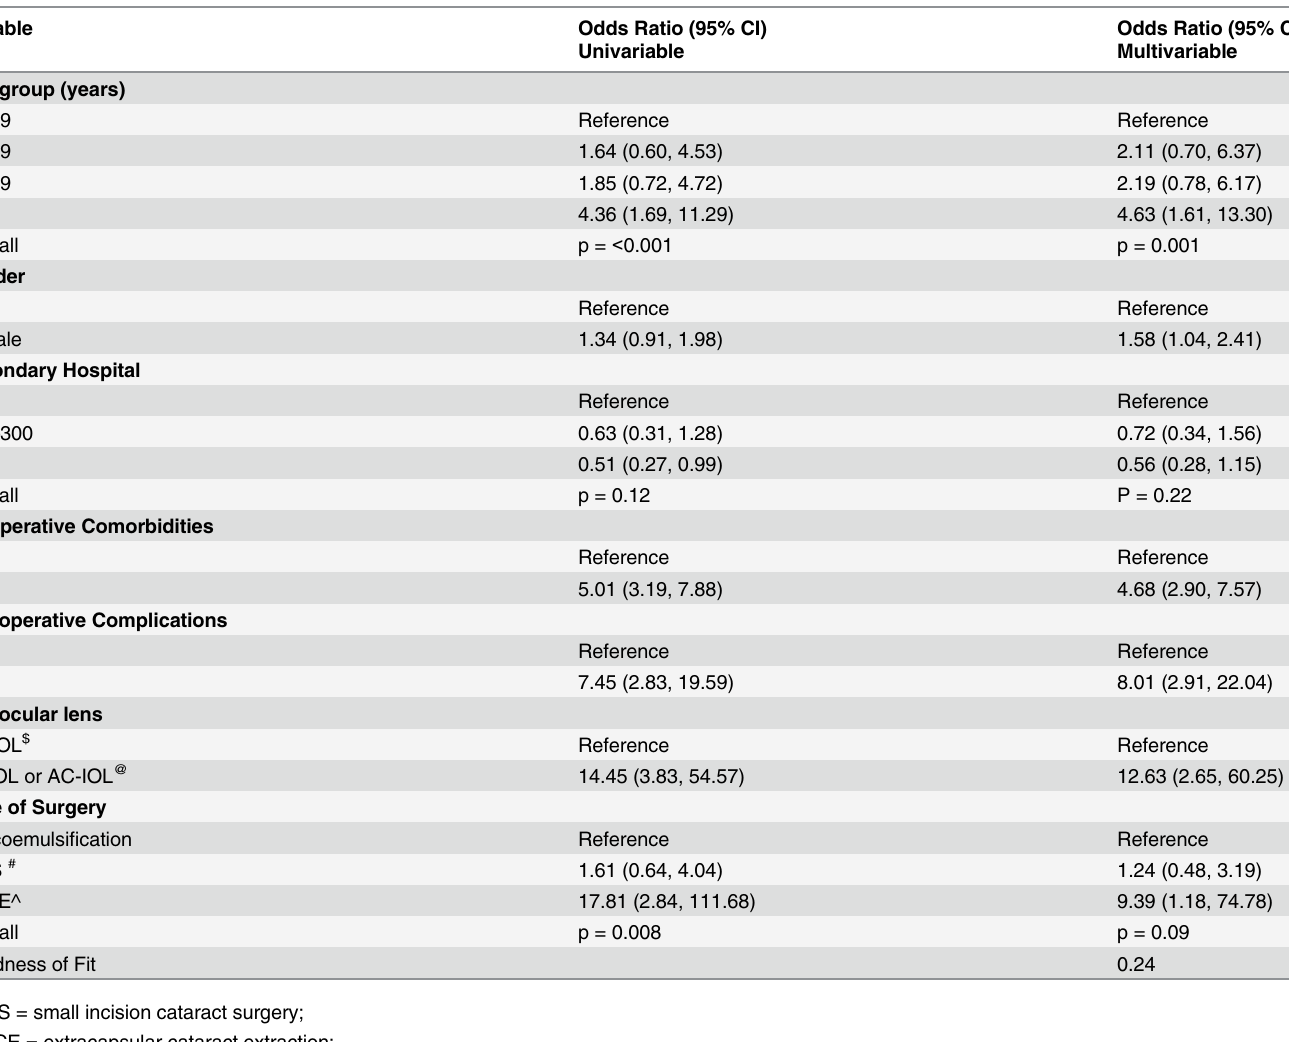
Table 6. Univariable and multivariable association of demographic, location and surgical factors with visual outcome at 4 – 11 weeks